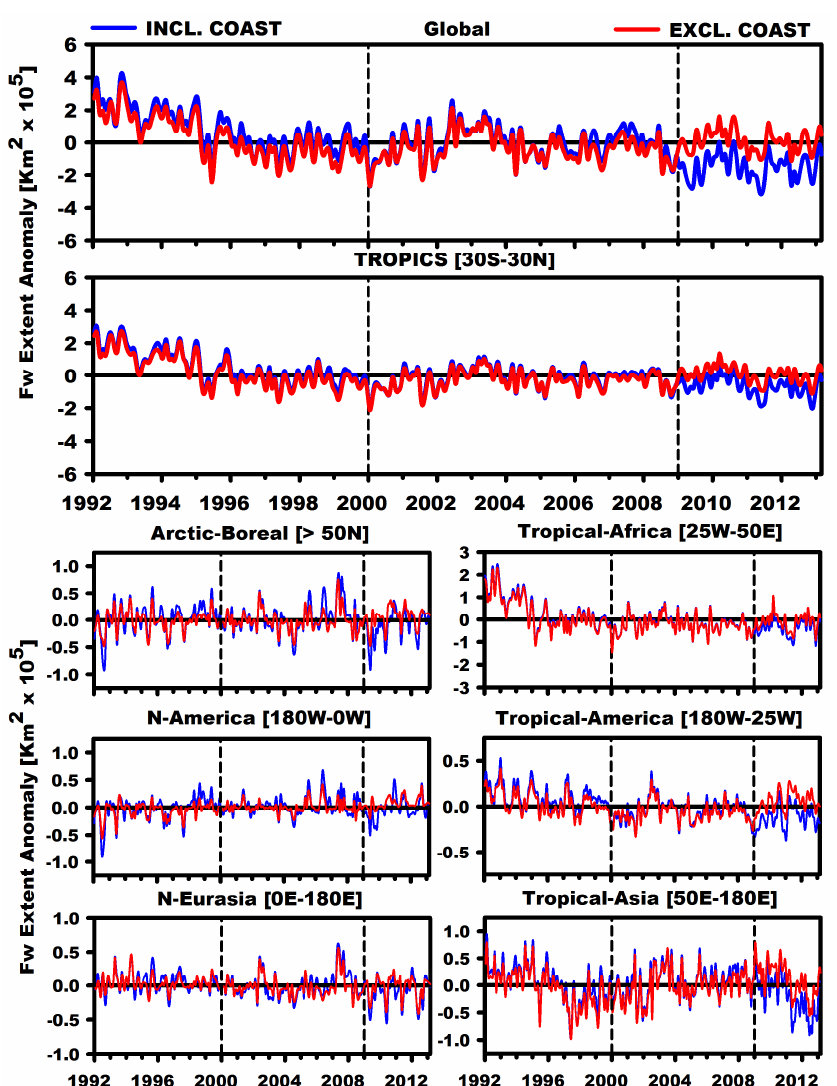
Figure 14. Deseasonalized monthly FW extent anomalies for the combined v1-ERS (1992–1999), v1-QSCAT (2000–2008) and v2-ASCAT (2009–3/2013) SWAMPS time series over the global and regional domains. The deseasonalized anomalies are generated by subtracting the 22 year monthly climatology (1992–3/2013) from individual monthly means.